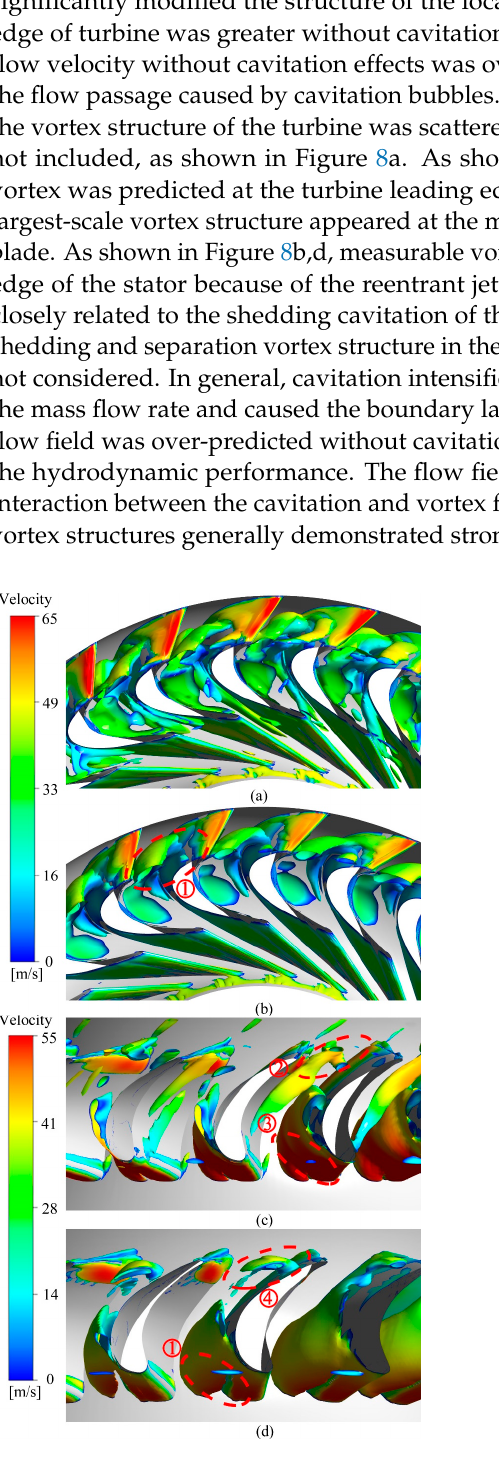
Figure 8. Vortex distribution near the turbine and stator blades under non-cavitation and cavitation conditions ( Q = 2.4085 × 10 6 s − 2 ). ( a ) vortex distribution without cavitation (turbine), ( b ) vortex dis- tribution with cavitation (turbine), ( c ) vortex distribution without cavitation (stator), and ( d ) vortex distribution with cavitation (stator). (1-separation vortex, 2-scatter vortex, 3-attached vortex, and 4- shedding vortex, ( SR = 0). Figure 9 shows unsteady cavitation in the stator and turbine domains under the stall operating condition. There was no measurable cavitation in the pump domain, where the pressure was high because of the high rotation speed. The cavitation in the turbine domain can be classified as stable attached cavitation. The stator cavitation was an unstable cloud